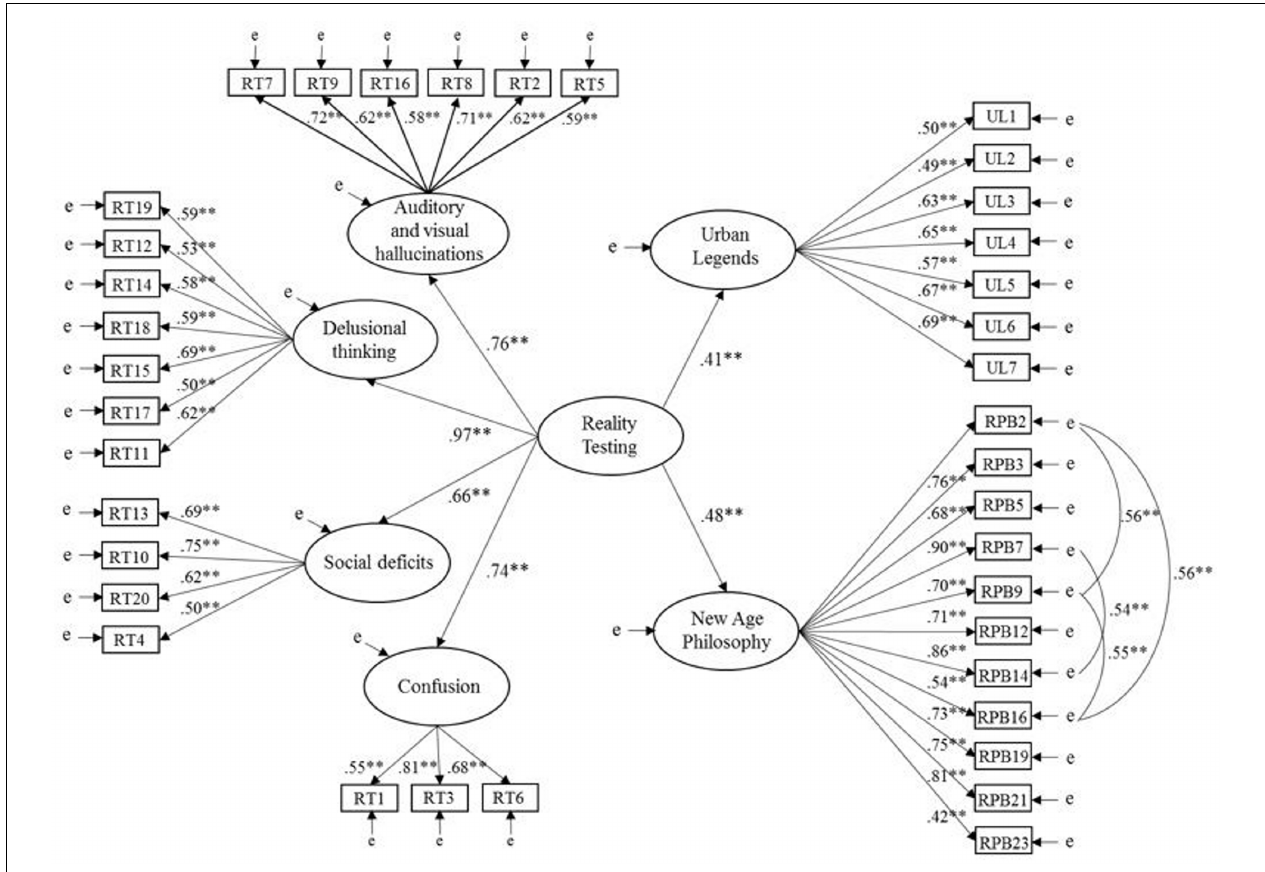
FIGURE 2 | Model 4: relationships of reality testing with new age philosophy and urban legends. Latent variables are represented by ellipses; observed variables are represented by rectangles; error of measurement is indicated by ‘e’; ∗ p < 0.05, ∗∗ p <